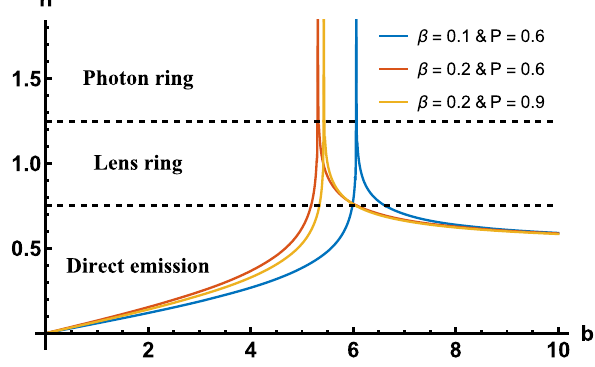
Fig. 11 The relationship between the total laps of photons rotating the black hole n and the impact parameter